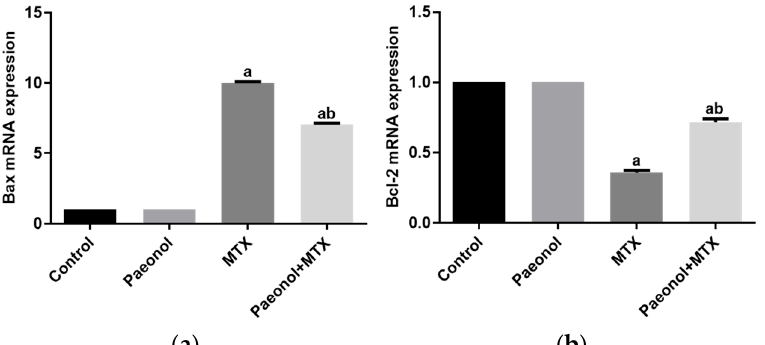
Figure 11. The effect of paeonol on hepatic mRNA expressions of Bax ( a ) and Bcl-2 ( b ) in methotrexate (MTX)-induced hepatotoxicity in rats. Data are represented as mean ± SEM ( n = 6). Letters a,b Denote significant differences from the normal control and the MTX groups, respectively, at p ˂ 0.05.